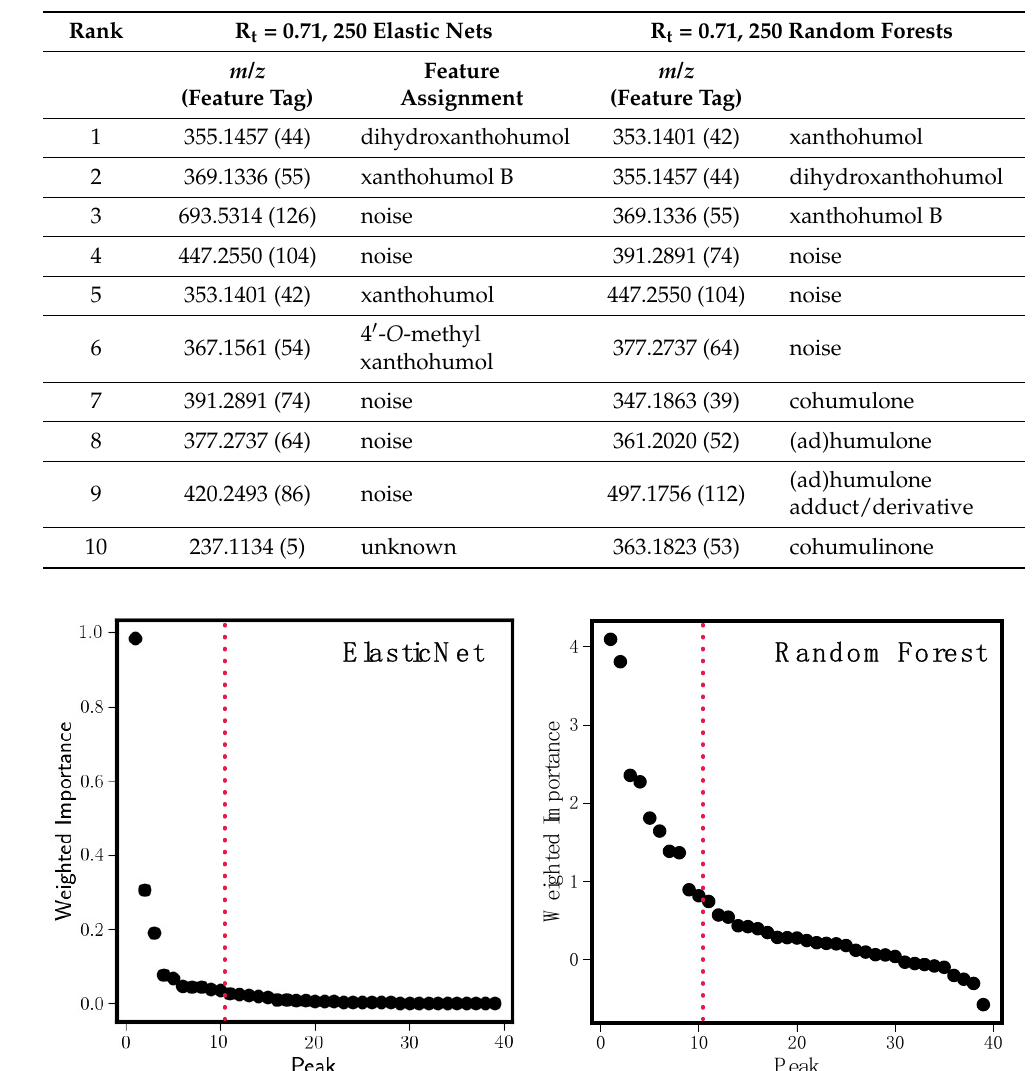
Figure 4. Weighted importance plots for Elastic Net model ensembles ( left ) and Random Forest model ensembles ( right ). Importances have been sorted from largest to smallest and there is no correspondence between peak numbers in the left and right panels. The rapid falloff in importance (extreme in the Elastic Net case) is typical for our method. Dotted lines are drawn after the first ten peaks in each model; these are the peaks we annotate in Table 1. Table 1. Top 10 ensemble bioactive compounds from 250 Elastic Nets (Column 2) and 250 Random Forests (Column 3). Before generating model ensembles, reproducibility filtering was performed using a threshold of r t = 0.71. Feature assignments were made by comparison with in-house library spectra or online database spectra: dihydroxanthohumol (=α,β-dihydroxanthohumol [6]), xantho- humol [39], xanthohumol B [39], 4′- O -methylxanthohumol [40], cohumulone [41], adhumulone [42], and cohumulinone [43]. Feature no. 112 was partially characterized as an adhumulone adduct or derivative because it produced fragment ions that were identical to those observed in the MS/MS spectrum of (ad)humulone (feature no. 52). Humulone and adhumulone are isobaric isomers that differ in the substitution of the aromatic ring, i.e., 3-methylbutanoyl versus 2-methylbutanoyl, re- spectively. Rank